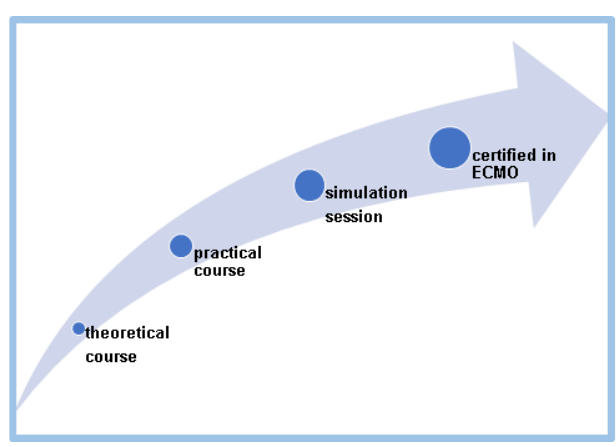
Fig. 2 - ECMO training program stages.